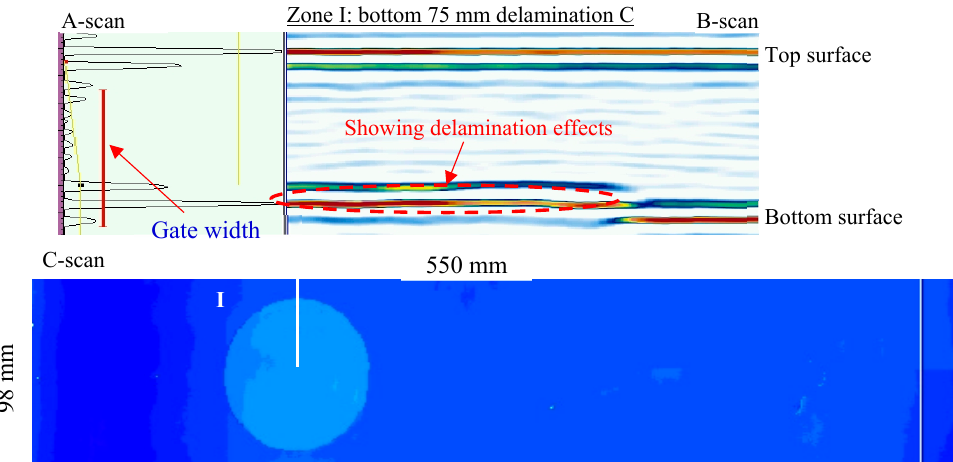
Figure 9. NDT results of the second inspection area on the unidirectional [0] 30 CFRP composite plate: bottom 75 mm delamination.